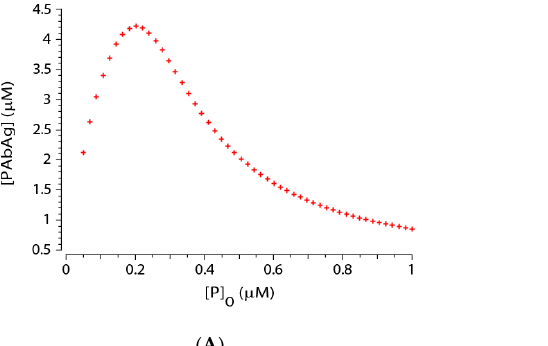
Figure 7. Dependences of analyte determination at different concentrations of labeled antigen ( A ) Theoretical dependence ob- tained by numerical simulation. Model parameters: T = 60 s; [P] 0 = 5 × 10 − 7 M; [Ag] 0 = 10 − 5 M; ka = 10 5 1/(M*s); kd = 2.5 × 10 − 3 1/s. ( B ). Experimental values of the color intensity (signal from the Reflekom analyzer) of analytical zones after the assay at different optical densities (D520) of the label conjugate.